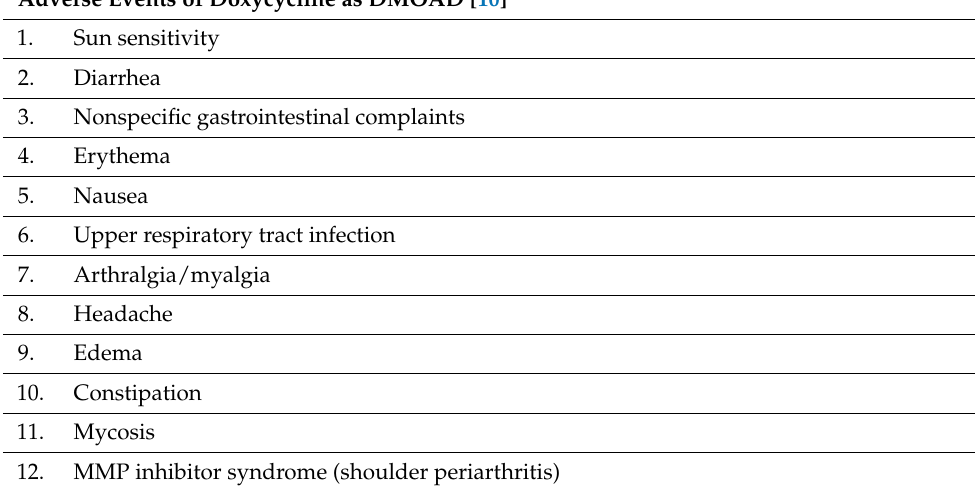
Table 2. Adverse events of